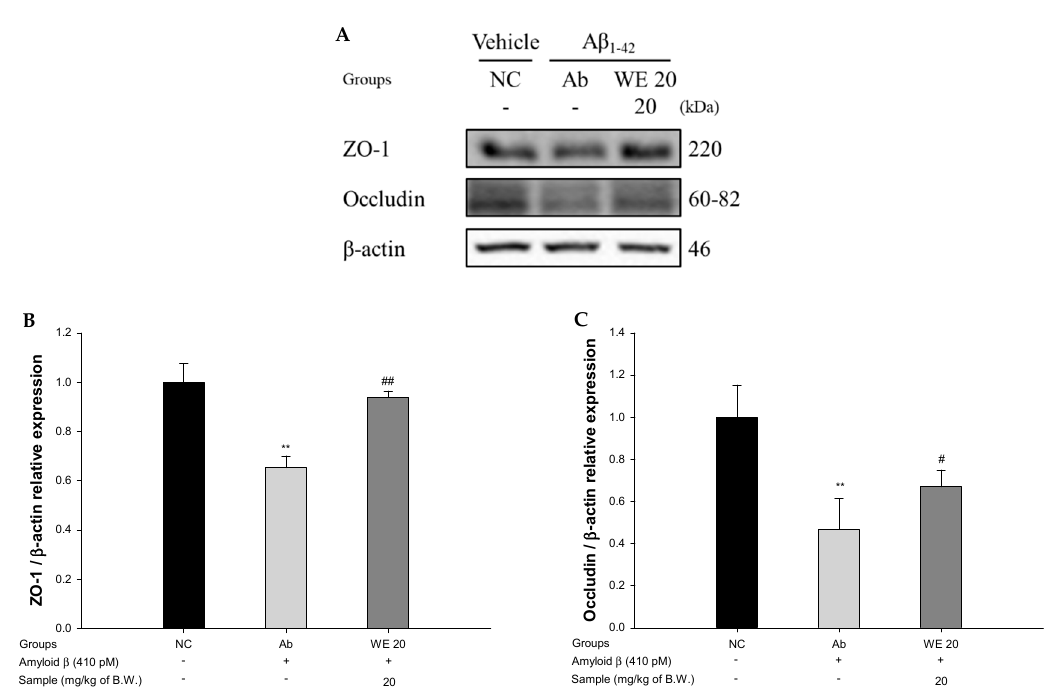
Figure 7. Protective effect of walnut ( Juglans regia L.) extract on A β -induced blood brain barrier (BBB) dysfunction: ( A ) protein expression levels; ( B ) representative Western blots for total protein and expression of zonula occludens-1 (ZO-1) ( C ) and occludin in mice brain tissues. Result shown are means ± SD ( n = 3). Data are statistically represented at * = significantly different from the NC group; # = significantly different from Ab group; # p < 0.05, ** and ## p < 0.01.